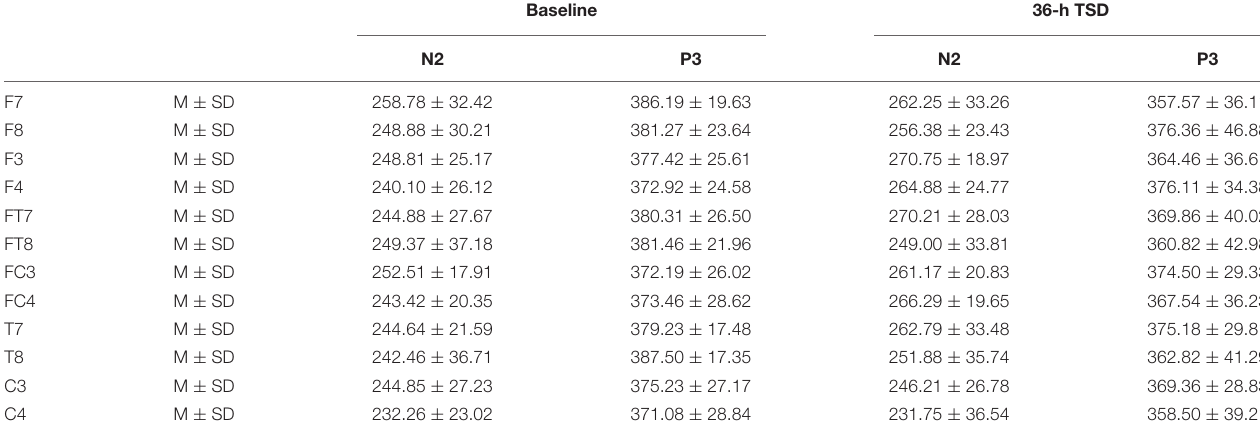
FIGURE 4 | Topographic map of correct response during working memory task across different sleep conditions (A–C) . (A) P3, 250–450 ms, at baseline. (B) P3, 250–450 ms, after 36-h TSD. (C) P3, 250–450 ms, 36-h TSD baseline subtracted. TABLE 3 | The average peak latency of the N2 and P3 components in the correct response condition across multiple electrode sites at baseline and after 36-h TSD. Baseline 36-h